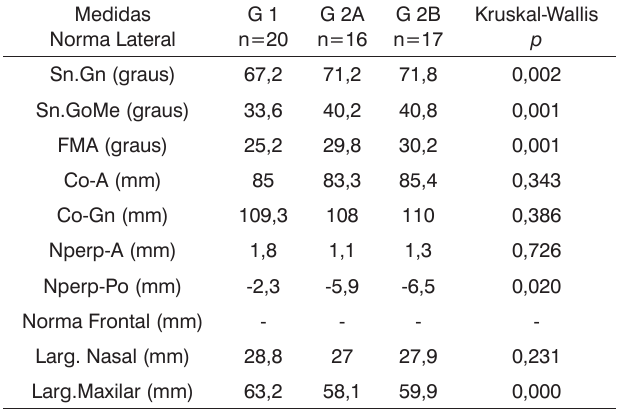
Tabela 1. Médias intergrupos das variáveis Iniciais .